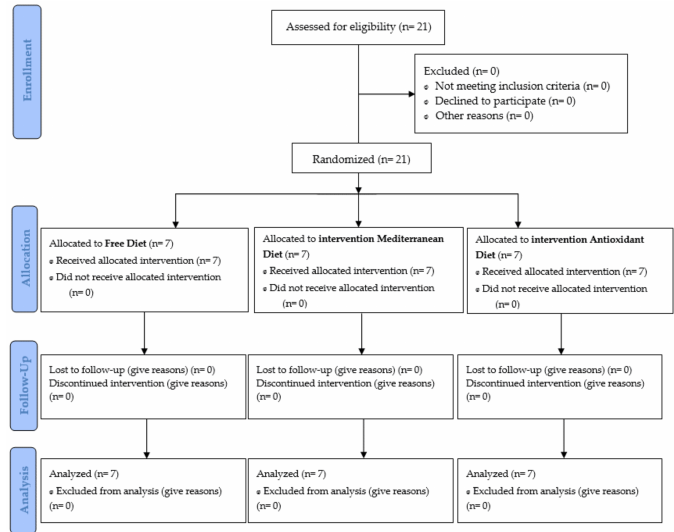
Figure 2. Consort Flow Diagram.